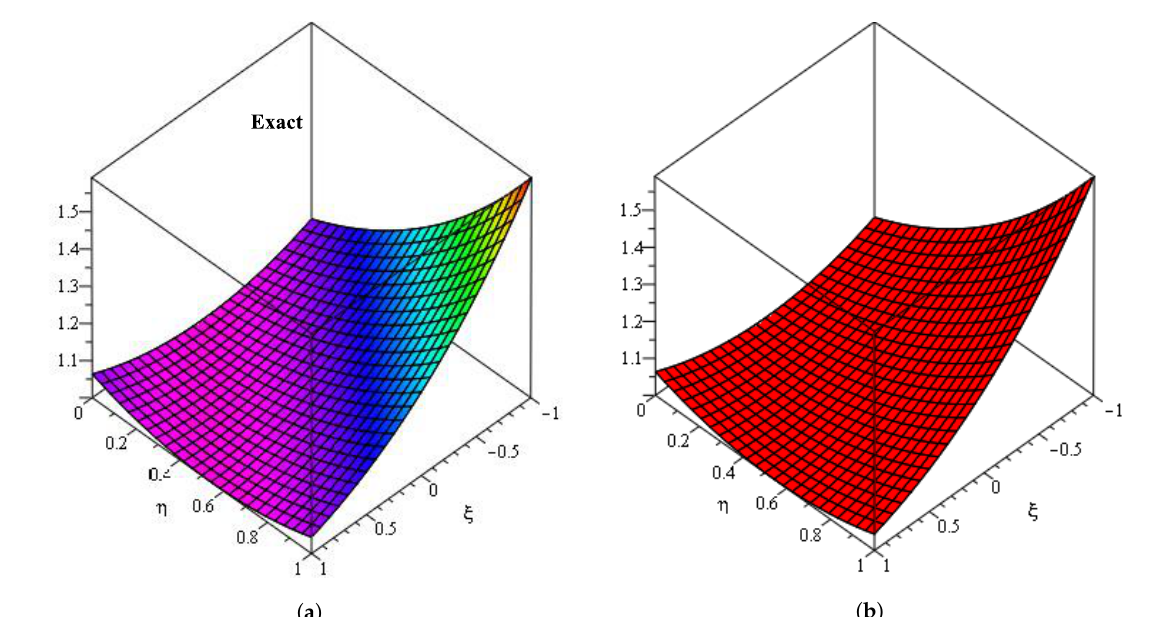
Figure 5. ( a ) Exact solution plot of example 2. ( b ) Comparison between approximate solution by SDM and VITM plot of Example 2 at γ = 1.